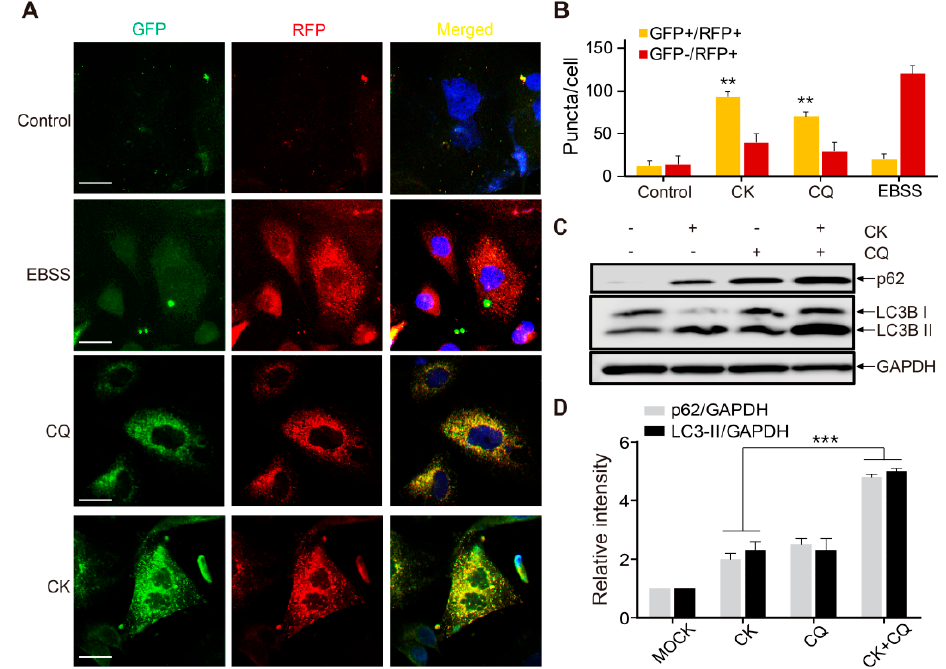
Figure 6. CK inhibits the fusion of autophagosome and autolysosomes. ( A ) mRFP-GFP-LC3B stable SK-N-BE(2) cells were treated with autophagy inhibitor (CQ) and then exposed to CK (5 µ M) or starved in EBSS for 24 h. The treated cells were fixed and imaged with fluorescence microscopy. Scale bar: 50 µ m. ( B ) Quantitative analysis of double positive (GFP + / RFP + ) and single positive (RFP + ) puncta per cell in control, Earle’s balanced salt solution (EBSS)-, CQ-, and CK-treated cells. Data are the mean values of three independent experiments with each count. Values are expressed as the mean ± SD. **: p < 0.01 versus control. ( C ) CK increased p62 and LC3B-II expression. SK-N-BE(2) cells were treated with CK for 24 h with or without CQ (10 µM). ( D ) The protein level of LC3B and p62 was analyzed by western blot. Results were normalized to GAPDH. Data are presented as mean ± standard deviation (SD). ***: p < 0.001 versus CK-treated cells. CK, Ginsenoside compound K; CQ, chloroquine.